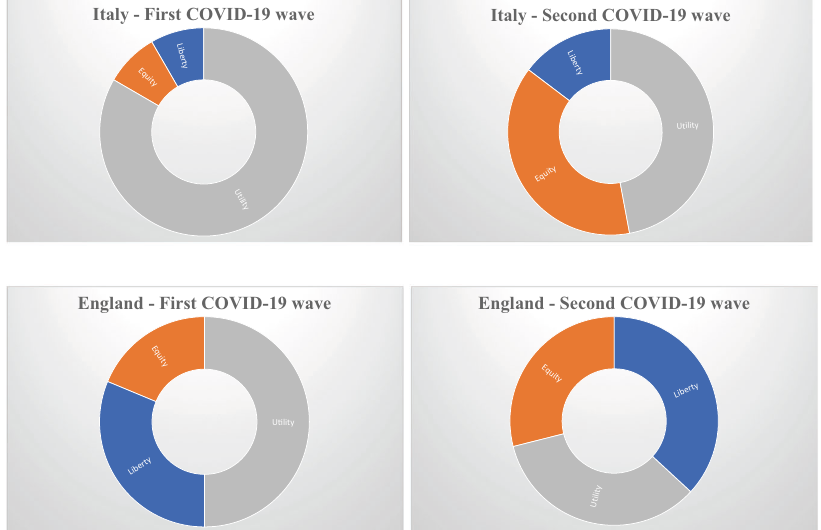
Fig. 1 Evolution of value trade-off. Evolution of the value trade-off embedded in the COVID-19 containment policies promulgated in Italy and in England, during the fi rst and the second pandemic wave (until December